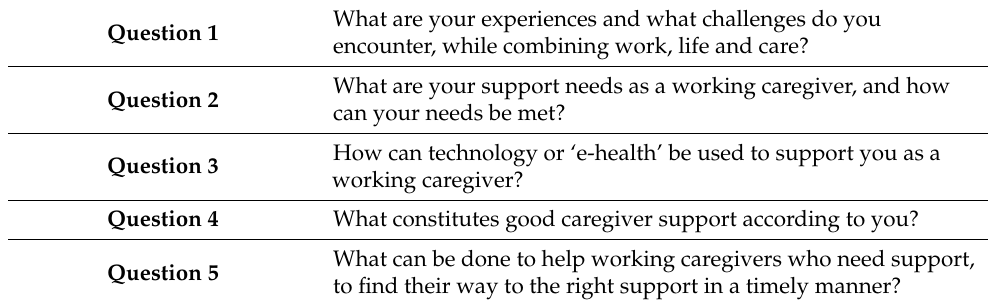
Table 1. Discussion guide for the online focus